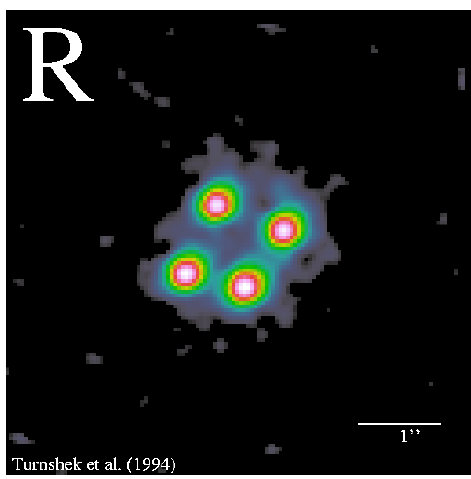
Figure 11. “Clover leaf” quasar H1413+117. The quasar was found in 1984 as a single object, then in 1988 it was discovered to be a lensed quasar split into four images. Image credit: NASA/STScI/D.Turnshek.